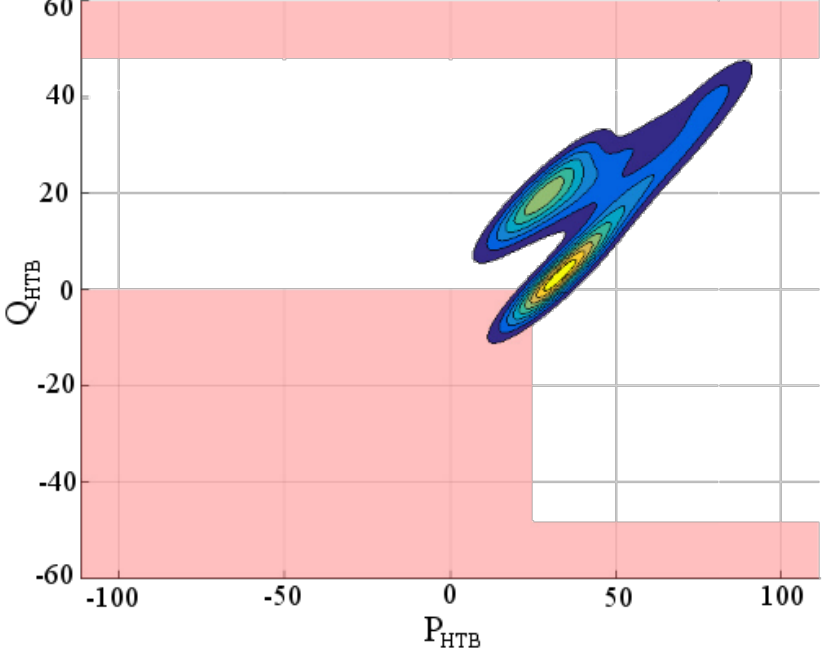
Figure 11. Stochastic PQ diagram at transmission and distribution grids interface with all capacitor banks (tap